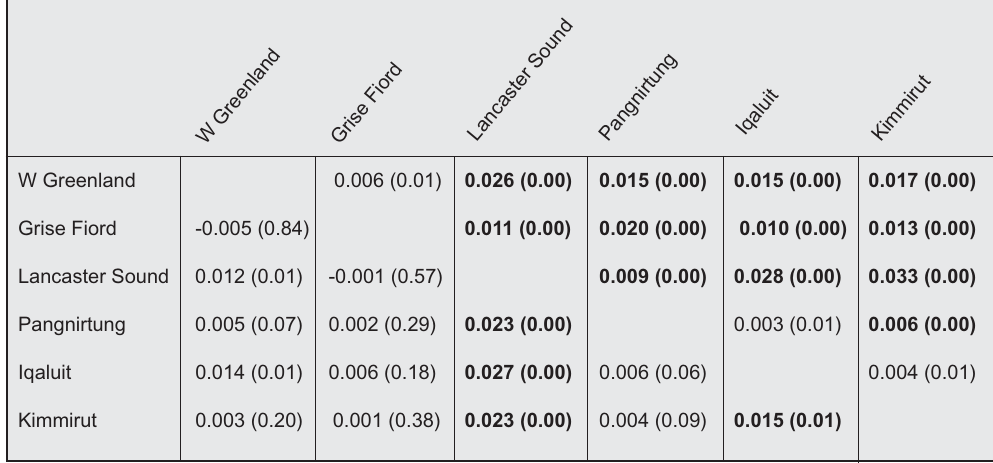
Table 4. Patterns of microsatellite differentiation among 6 beluga collections in West Greenland and the Canadian High Arctic. F values are above the diagonal, R values below. Associated st st probabilities from AMOVA are in parentheses. Minimum significance levels using table-wide criteria and table-wide α = 0.05 were P = 0.0125 and 0.0110, and probabilities below this level are